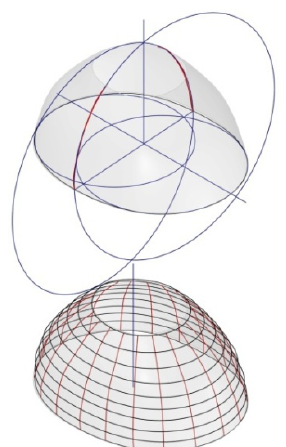
Figure 16. Dome of S. Giovanni Maggiore: ideal model